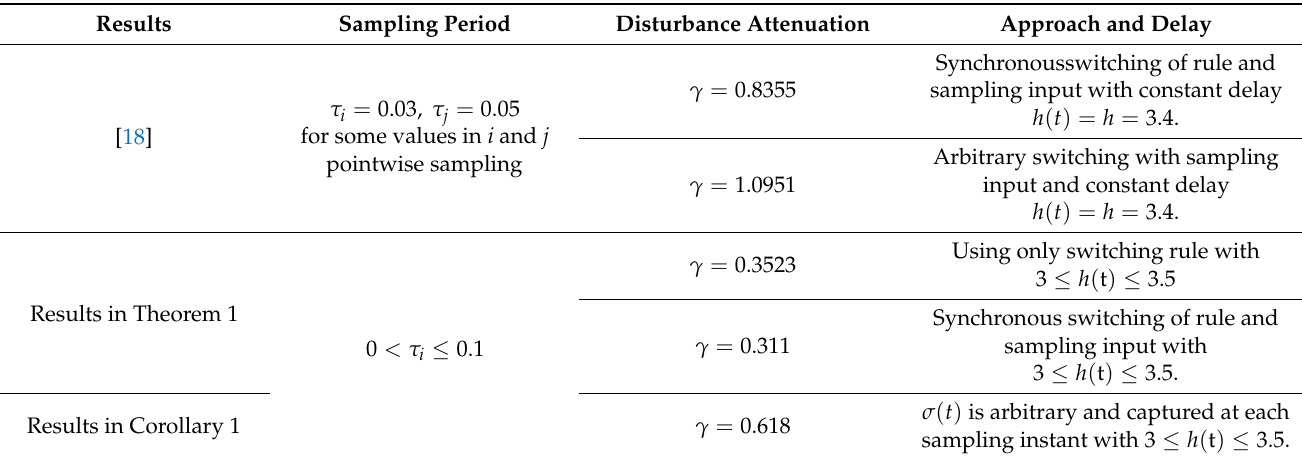
Table 2. Comparison of the obtained results with published ones.